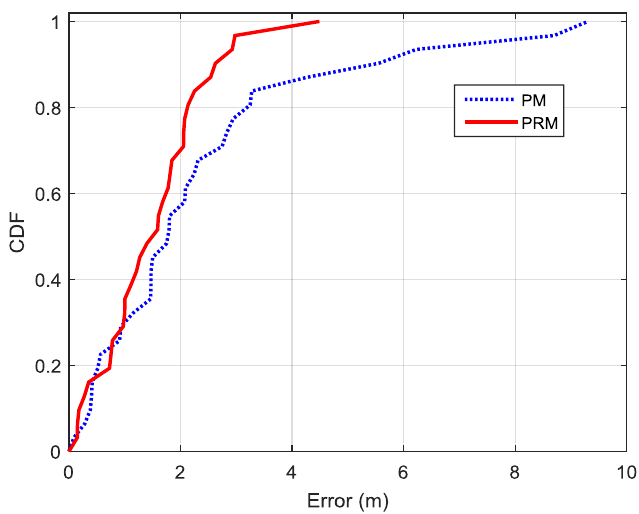
Figure 7. CDFs of distance estimation errors for the selected channel by using PM and PRM.